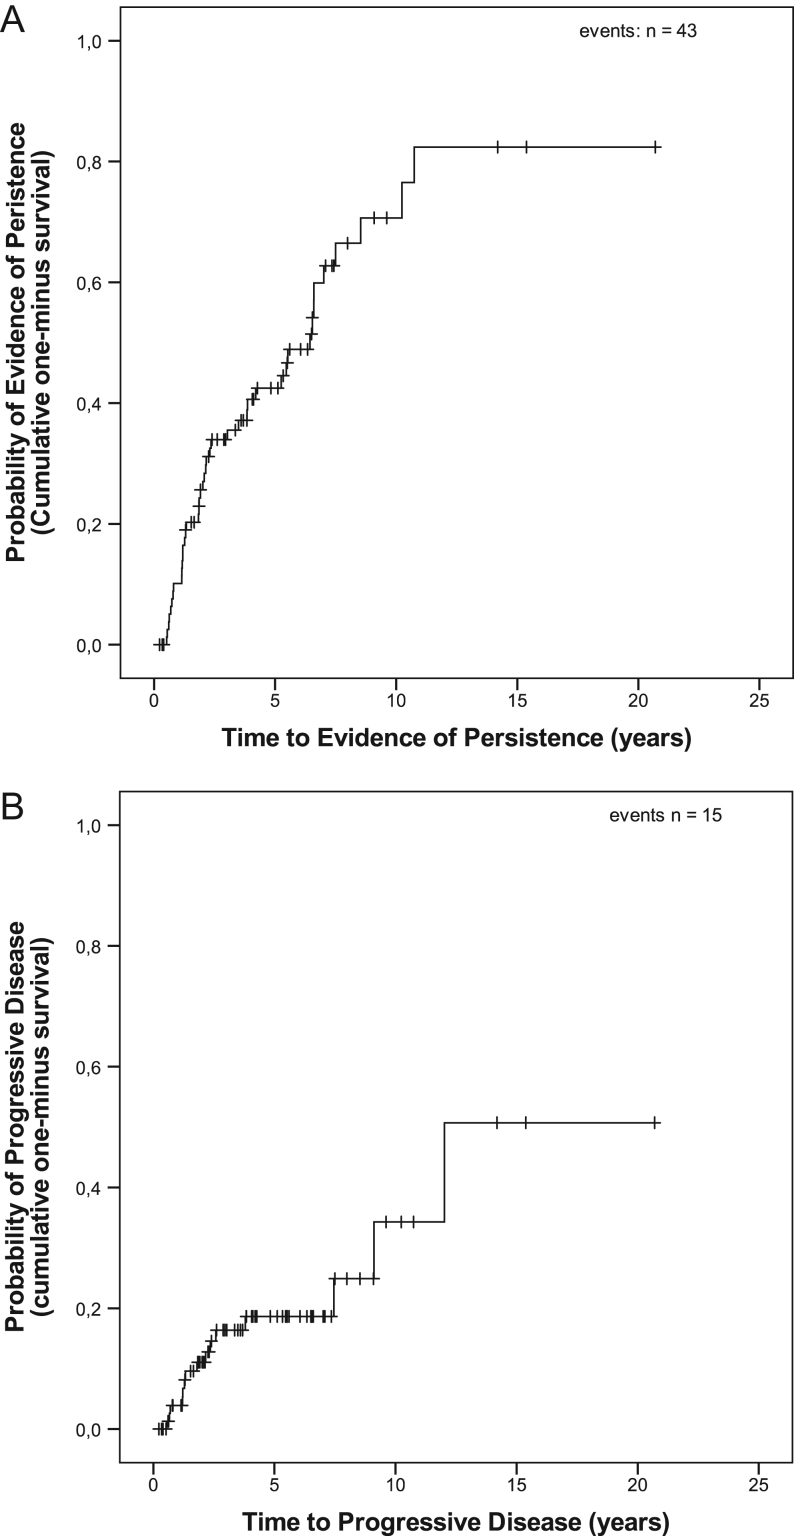
Kaplan–Meier analysis of secondary endpoints. (A) Time to evidence of persistence (TTEP) of patients with gNEN-1; EP, Evidence of Persistence defined as endoscopic and histopathologic rediscovery of gNEN-1 polyps during follow-up. s.e.m., standard error of mean; CI, confidence interval. Mean TTEP (years); s.e.m. (CI 95%): gNEN-1: 7.56; 1.098 (5.416–9.72). (B) Time to progressive disease (TTPD) in patients with gNEN-1; PD, progressive disease defined as transformation of histopathological grade (WHO 2010) and/or increased clinicopathological staging (pTNM/cTNM) during follow-up. s.e.m., standard error of mean; CI, confidence interval. Mean TTPD (years); SEM (CI 95%): gNEN-1:13.83; 1.75 (10.38–17.28).